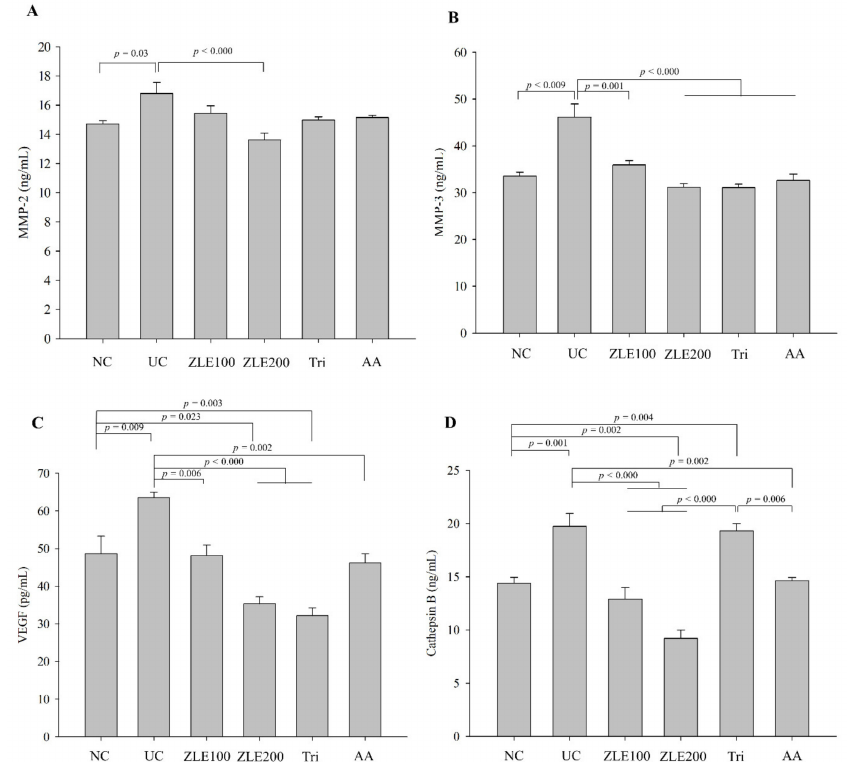
Figure 8. E ff ects of enzyme-treated Z. latifolia extract (ZLE) and tricin on the secretion of MMP-2, MMP-3, VEGF and cathepsin B in serum by UVA irradiation. ( A ) serum MMP-2; ( B ) serum MMP-3; ( C ) serum VEGF; ( D ) serum cathepsin B. The serum levels of the proteins were measured by ELISA. Data are expressed as the mean ± SE. The p values are determined by ANOVA and Tukey’s HSD